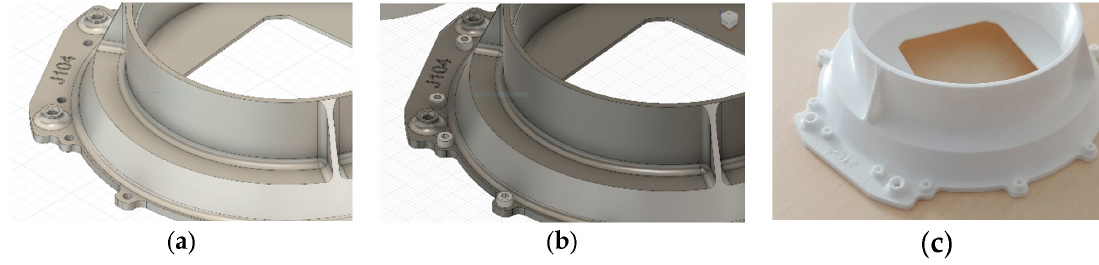
Figure 4. ( a ) Piece without screws in Fusion 360. ( b ) Piece with screws in Fusion 360. ( c ) Piece printed with screws.